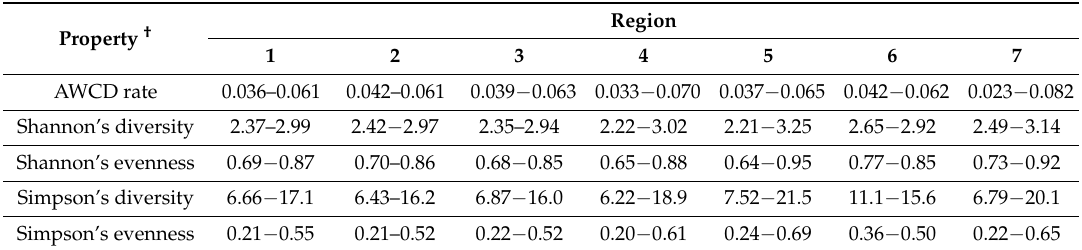
Table 3. Summary of minimum and maximum values for soil microbiological properties measured on EcoPlates TM [4] averaged across high- and average-yield areas and years (2014 and 2015) for the seven regions in the “Grow for the Green” yield contest across Arkansas. Values are rounded.